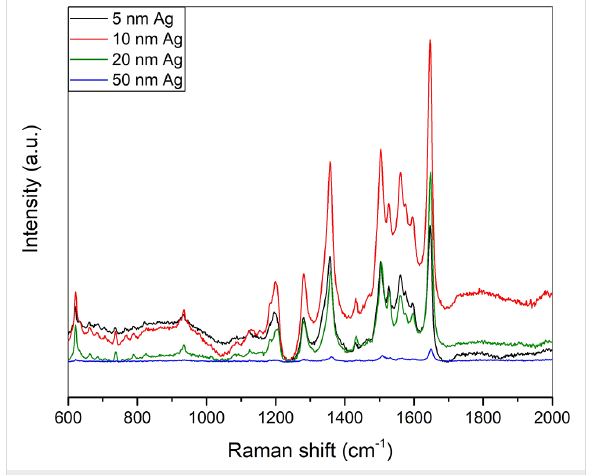
Figure 11: SERS spectra of 10 − 6 M RhB on sputtered silver films of different thicknesses.